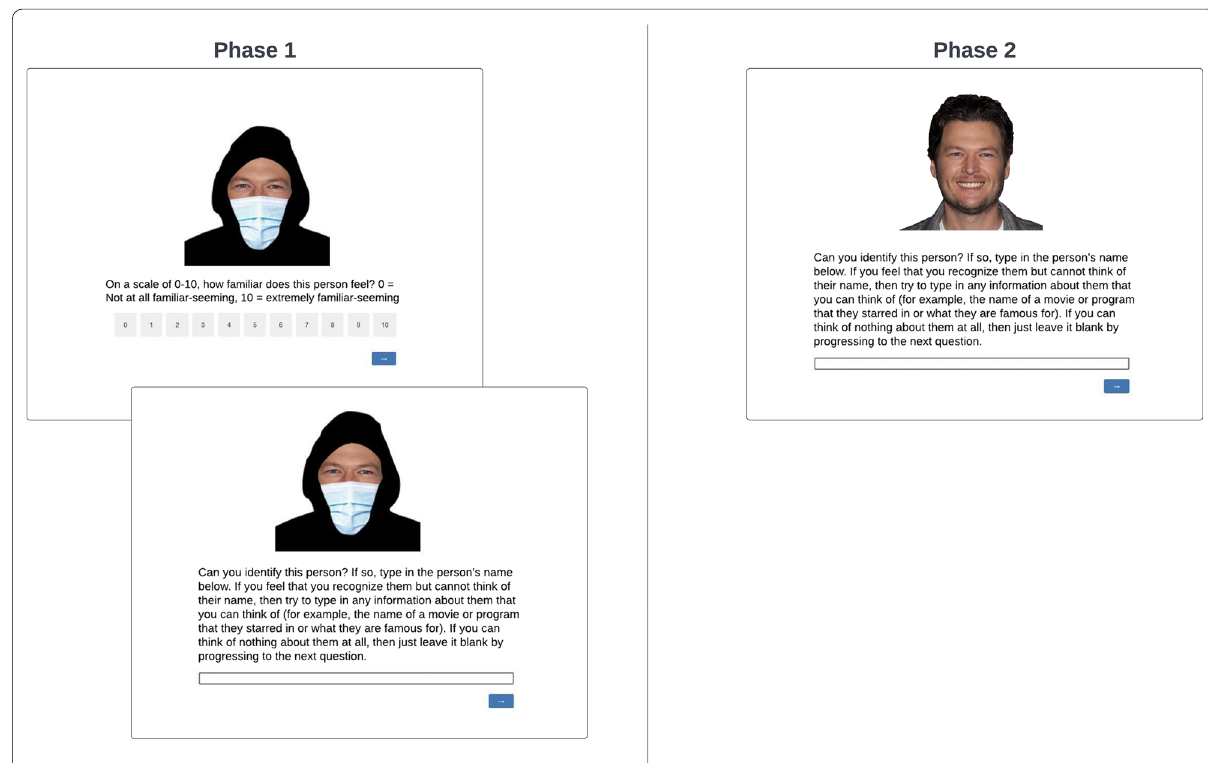
Fig. 1 Example of the procedure. The celebrity face Blake Shelton is depicted along with the prompts shown during Phase 1 and then unmasked and unhooded in Phase 2. Original celebrity image from DFree /